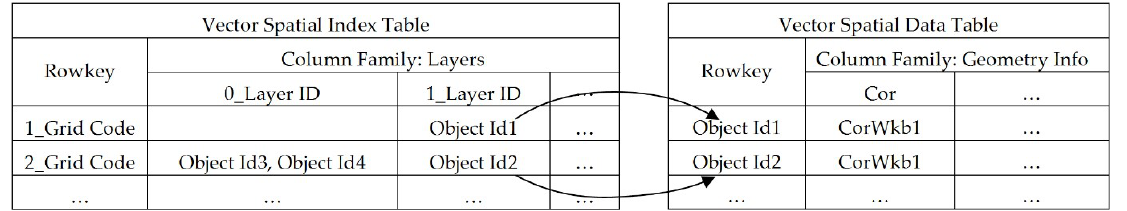
Figure 9. Table structure of the vector index and its relationship with the spatial data table.